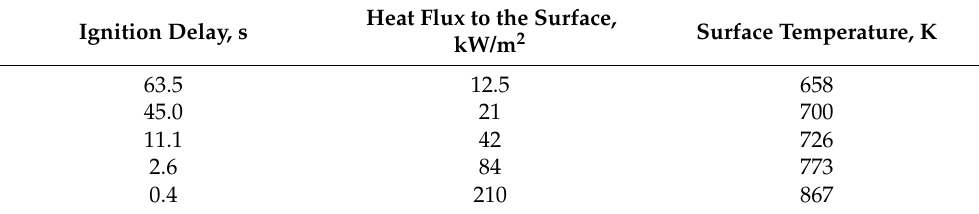
Table 2. Experimental data on wood ignition by radiant heat flux [63].